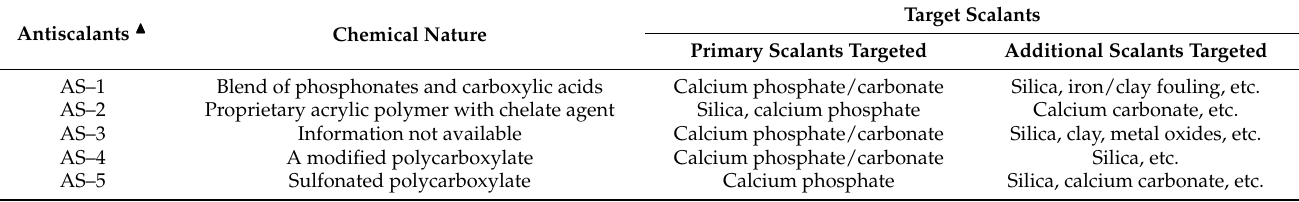
Table 2. Tested antiscalants as recommended by suppliers for increasing RO recovery to at least